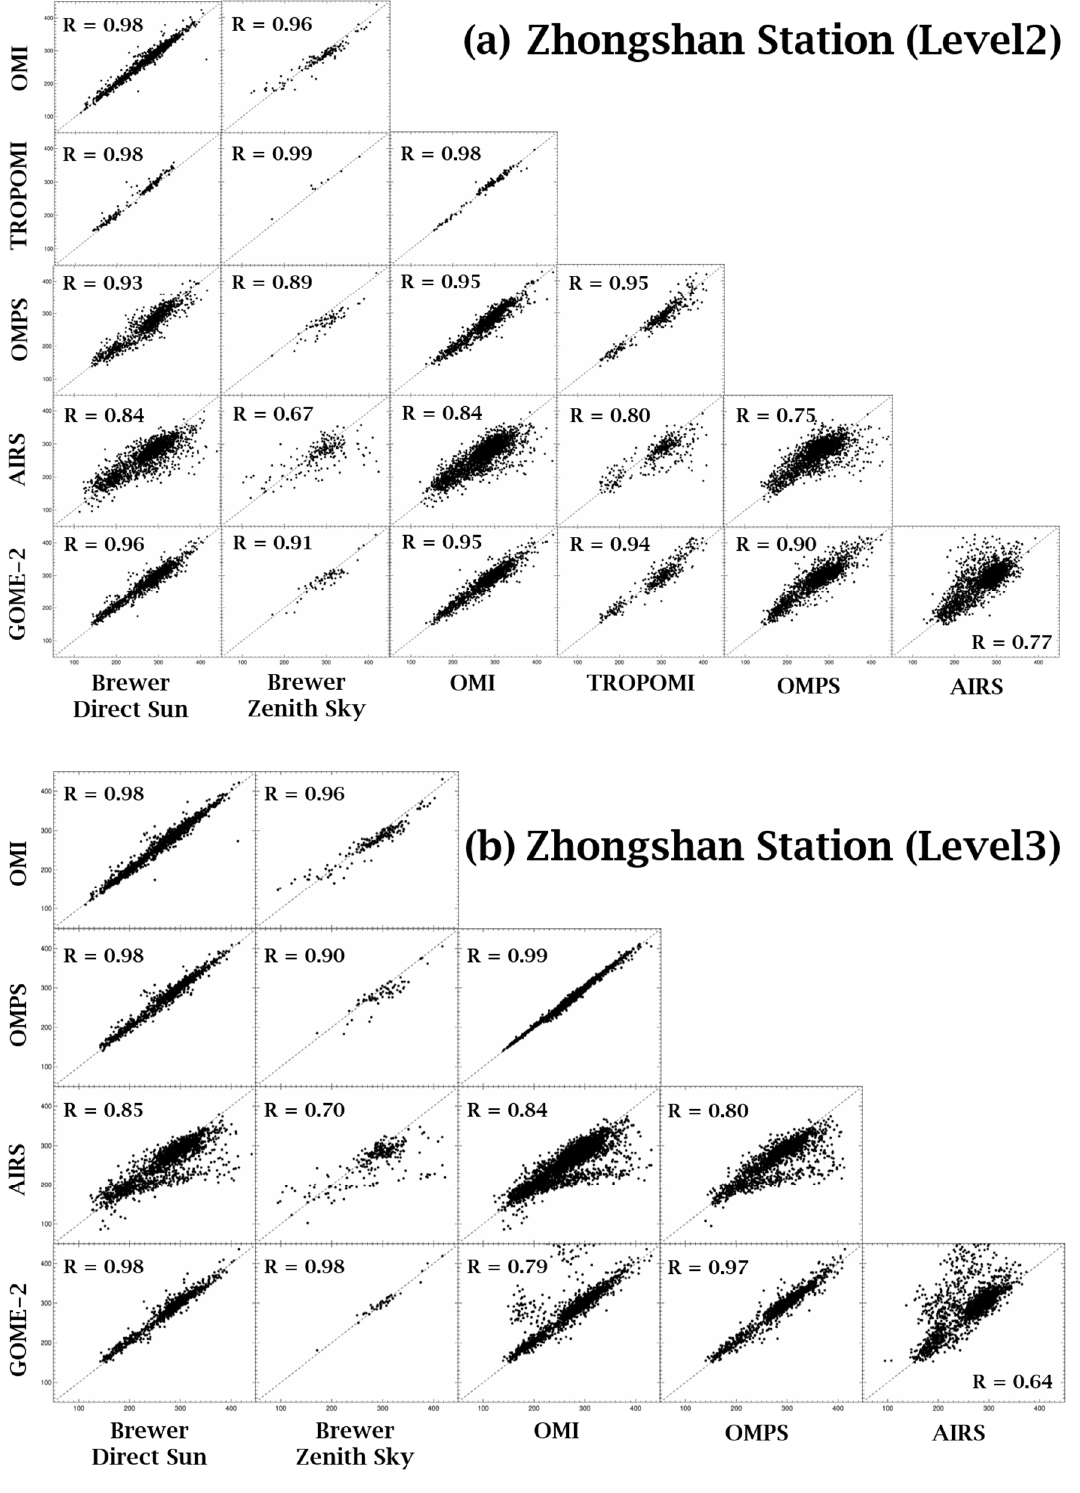
Figure 5. Scatterplots for the TOC comparison between satellite measurements and the Brewer measurements at the Zhongshan station: (a) Level 2; and (b) Level 3 TOC comparisons.